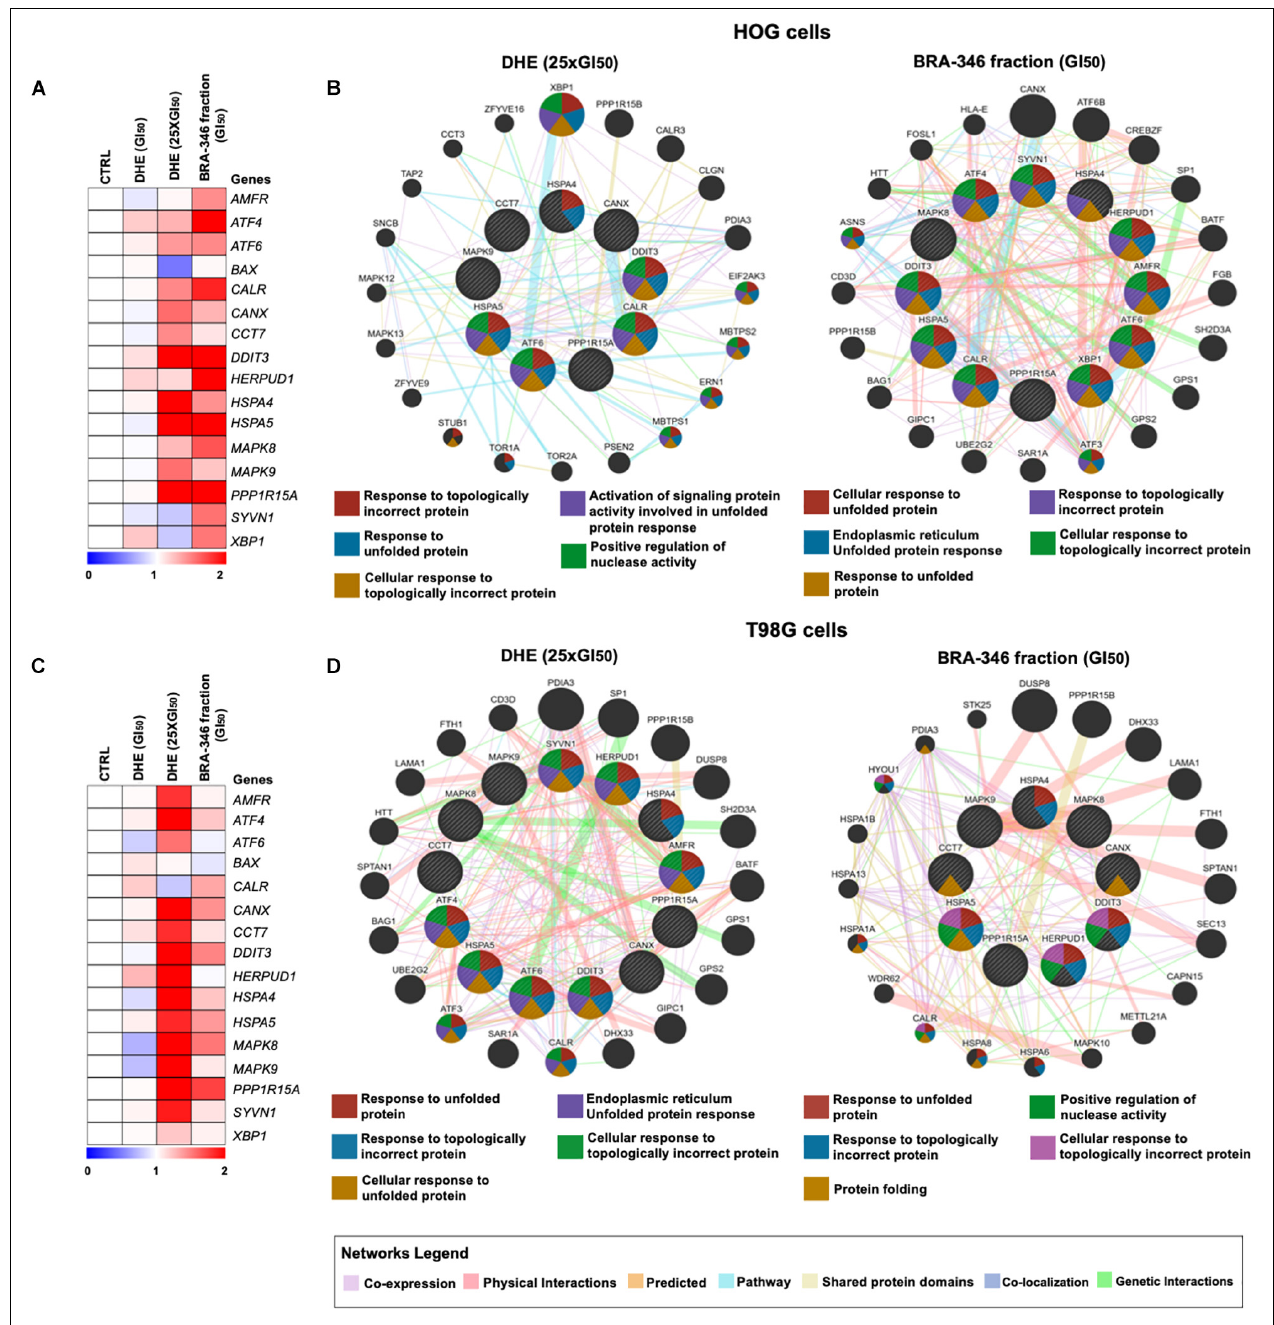
FIGURE 6 | Molecular changes promoted by dihydroeponemycin (DHE) and BRA-346 epoxyketone-containing fraction in glioma cells. (A,C) Heatmap of gene expression of HOG and T98G cells treated with DHE and BRA-346 epoxyketone-containing fraction for 36h. DHE was evaluated at GI 50 ( n = 1) and 25xGI 50 (40 ng/mL) ( n = 3), while the BRA-346 fraction was tested at GI 50 levels (17.6 and 28.2 ng/mL) ( n = 3). Values for relative expression were established in comparison to control values and the heatmap was constructed by MeV 4.9.0 software (http://mev.tm4.org). All genes analyzed are related to ER-stress, except for BAX , which mostly relates to apoptosis. (B,D) The networks illustrate interactions of 1.4-fold-change in genes modulated by DHE at 40 ng/mL and BRA-346 epoxyketone-containing fraction (17.6 and 28.2 ng/mL) treatment in HOG and T98G. The up-regulated genes in the quantitative PCR analysis are illustrated as crosshatched circles and the interacting genes included by software modeling are indicated by non-crosshatched circles. The main networks and function of genes are indicated by colored lines and color in circles are described in the legend.